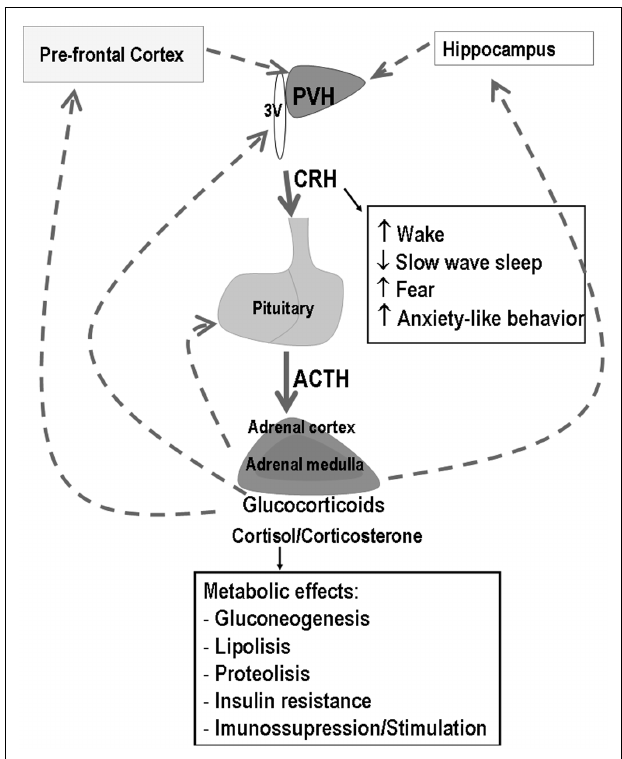
FIGURE 1 | Schematic representation of the hypothalamic– pituitary–adrenal (HPA) axis and main effects of corticotropin releasing hormone (CRH) and glucocorticoids (GC). Filled arrows represent stimulatory effects, whereas dotted arrows represent inhibition.The main sites of GC negative feedback are the prefrontal cortex, hippocampus, hypothalamus, and